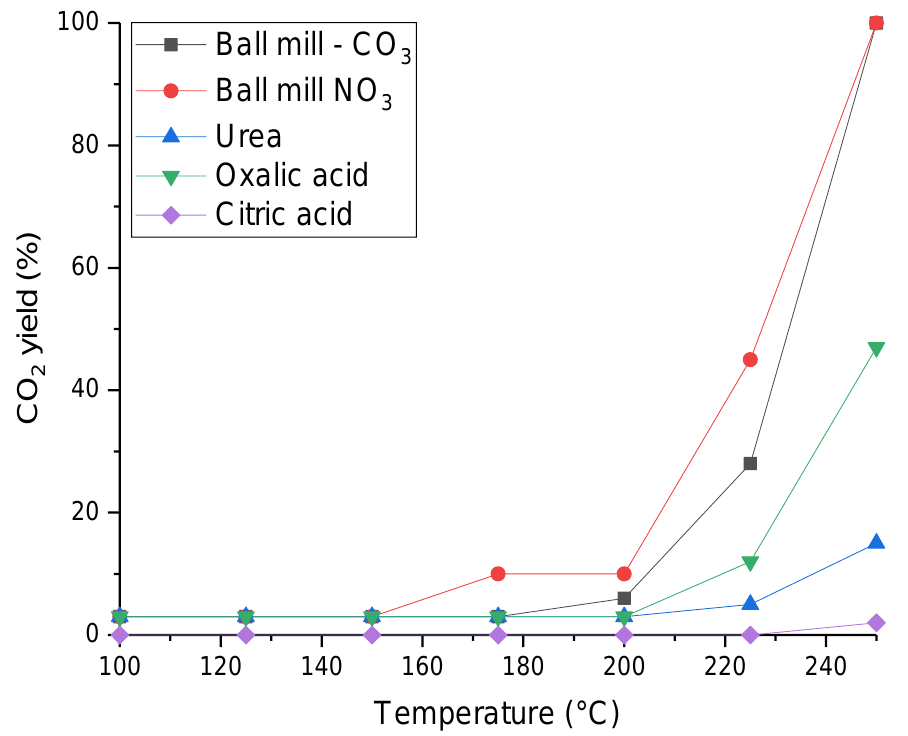
Figure 8. CO 2 yield as a function of temperature for the total oxidation of naphthalene for Ce 0.25 Mn 0.75 O x prepared by different synthesis techniques. Reaction conditions: 100 ppm naphtha- lene/20% O 2 /He, GHSV = 45,000 h −1 , Temperature range = 100 –250 °C.